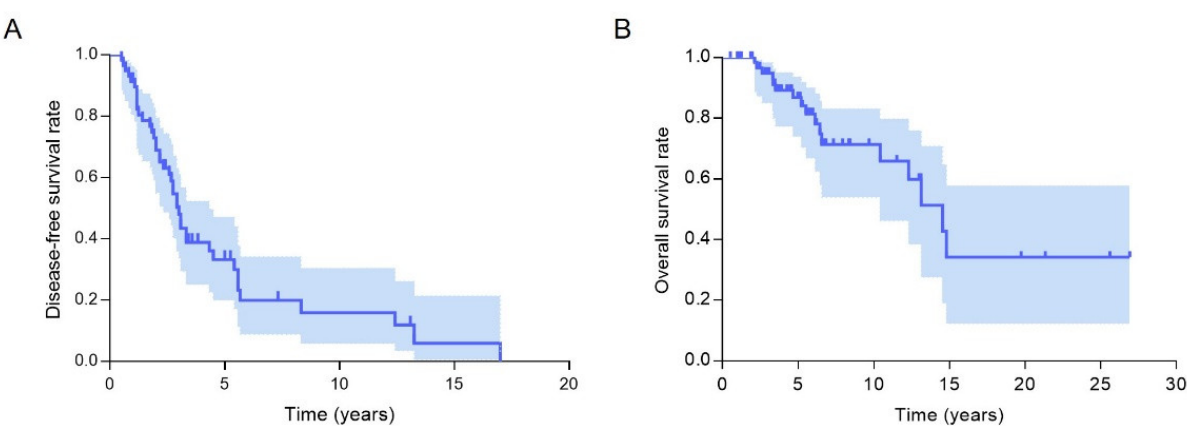
Figure 2. Cumulative disease-free survival ( A ) and overall survival ( B ) curves for patients with parathyroid carcinoma.